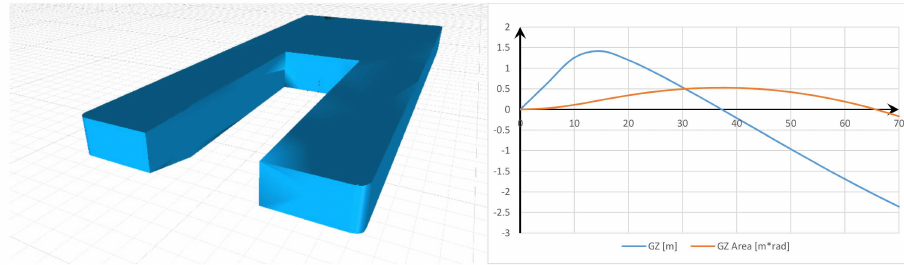
Figure 5. Model 2. GZ and Work (GZ Area) curve for initial